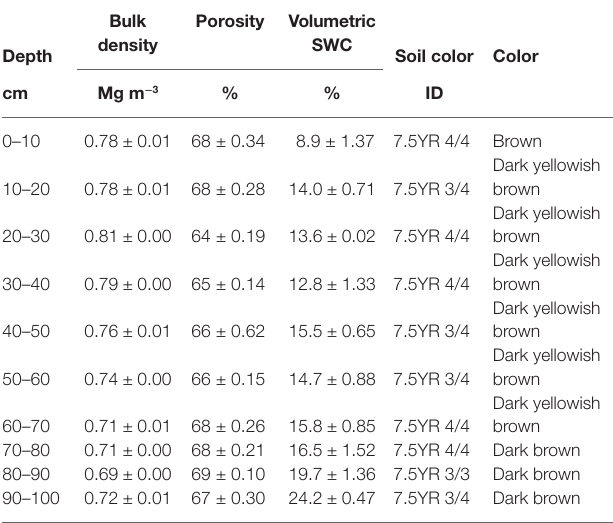
TABLE 2 | Physical properties of soil profile of the field experiment. Bulk Porosity Volumetric density SWC Depth Soil color